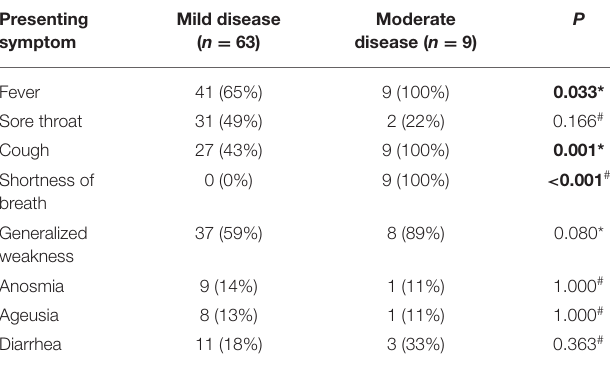
TABLE 1 | Showing presenting symptoms of non-severe COVID-19 patients with mild and moderate disease. Presenting symptom